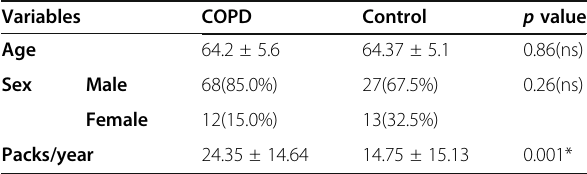
Table 1 Patient characteristics of studied populations